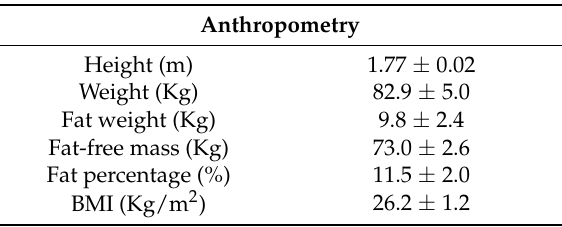
Anthropometric parameters of the athletes were measured and are shown here as mean ± standard error.